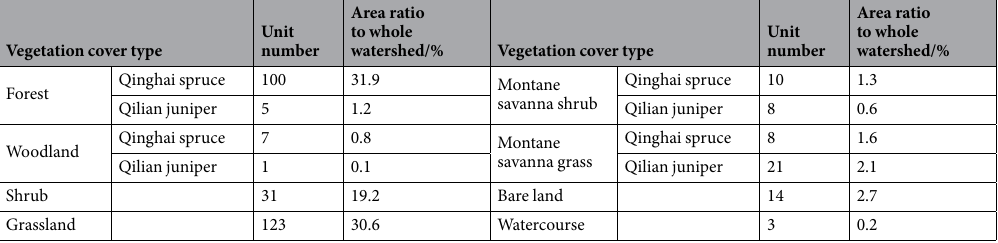
Table 1. The vegetation cover types and their area ratio in the Pailugou